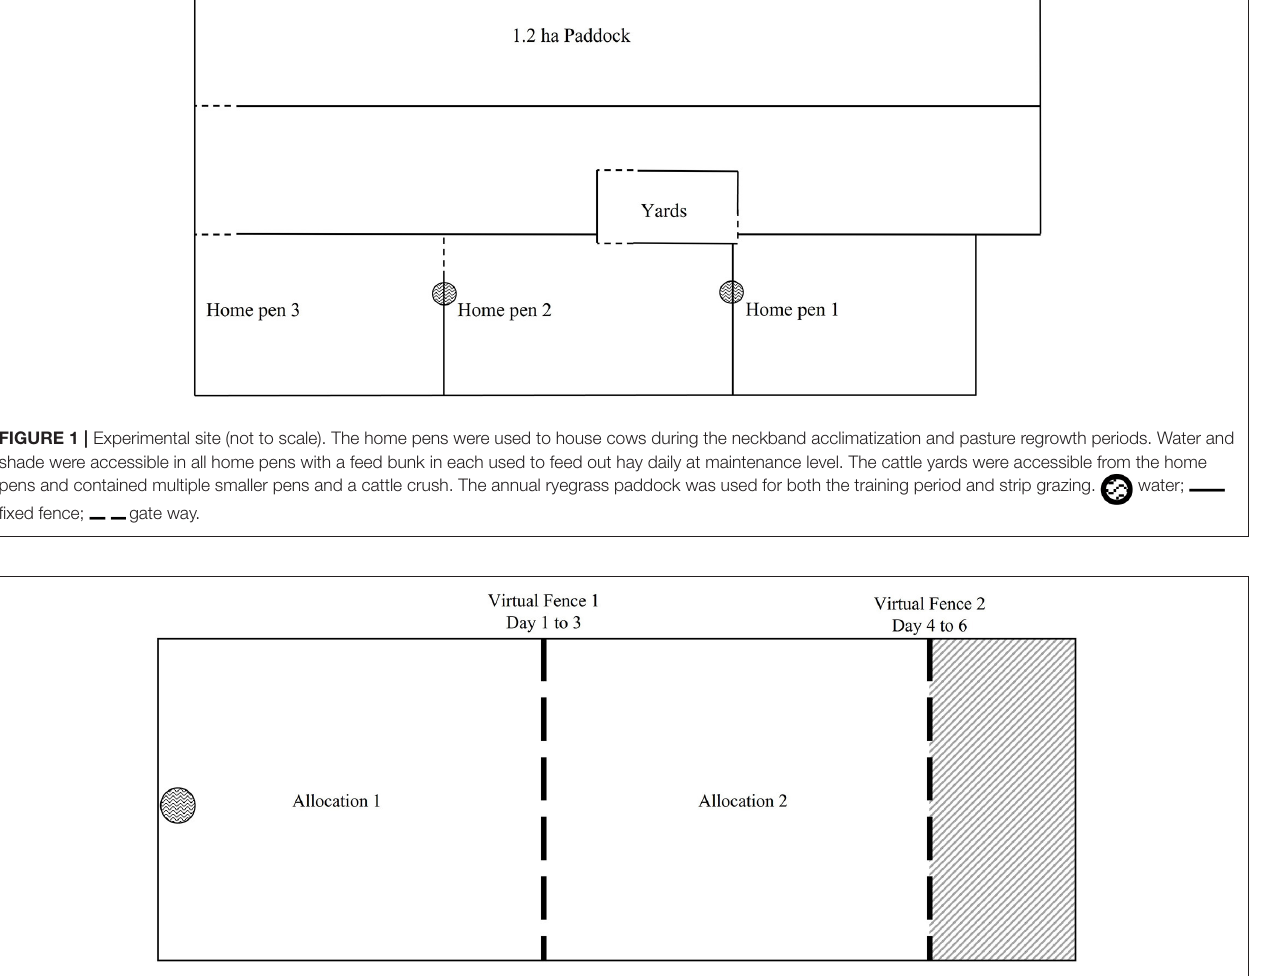
FIGURE 2 | Diagrammatic representation (not to scale) of the training paddock used to train dairy cows in each block before experimental work, as seen in Colusso et al. (2021) . The paddock was divided into three sections, allocation 1 (A1) and allocation 2 (A2). A1 was allocated for day 1–3 with the virtual fence 1 (VF1). At the end of day 3 the VF was moved forward to virtual fence two (VF2) to allow dairy cows access to A1 and A2. The remainder of the paddock (gray shaded area) remained unallocated, as it was the EZ for days 4–6. The water trough is